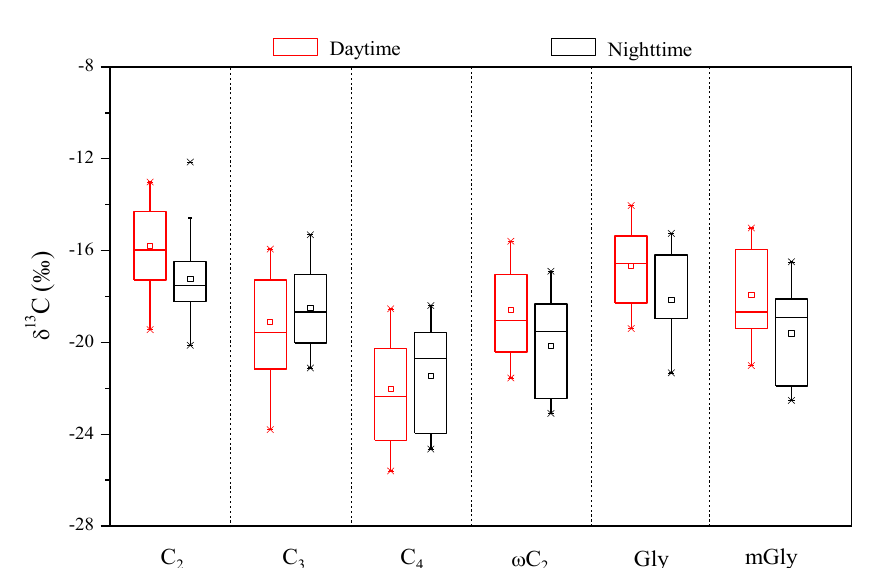
) with ( a ) O , ( b ) temperature (T), 2 3 ). IS